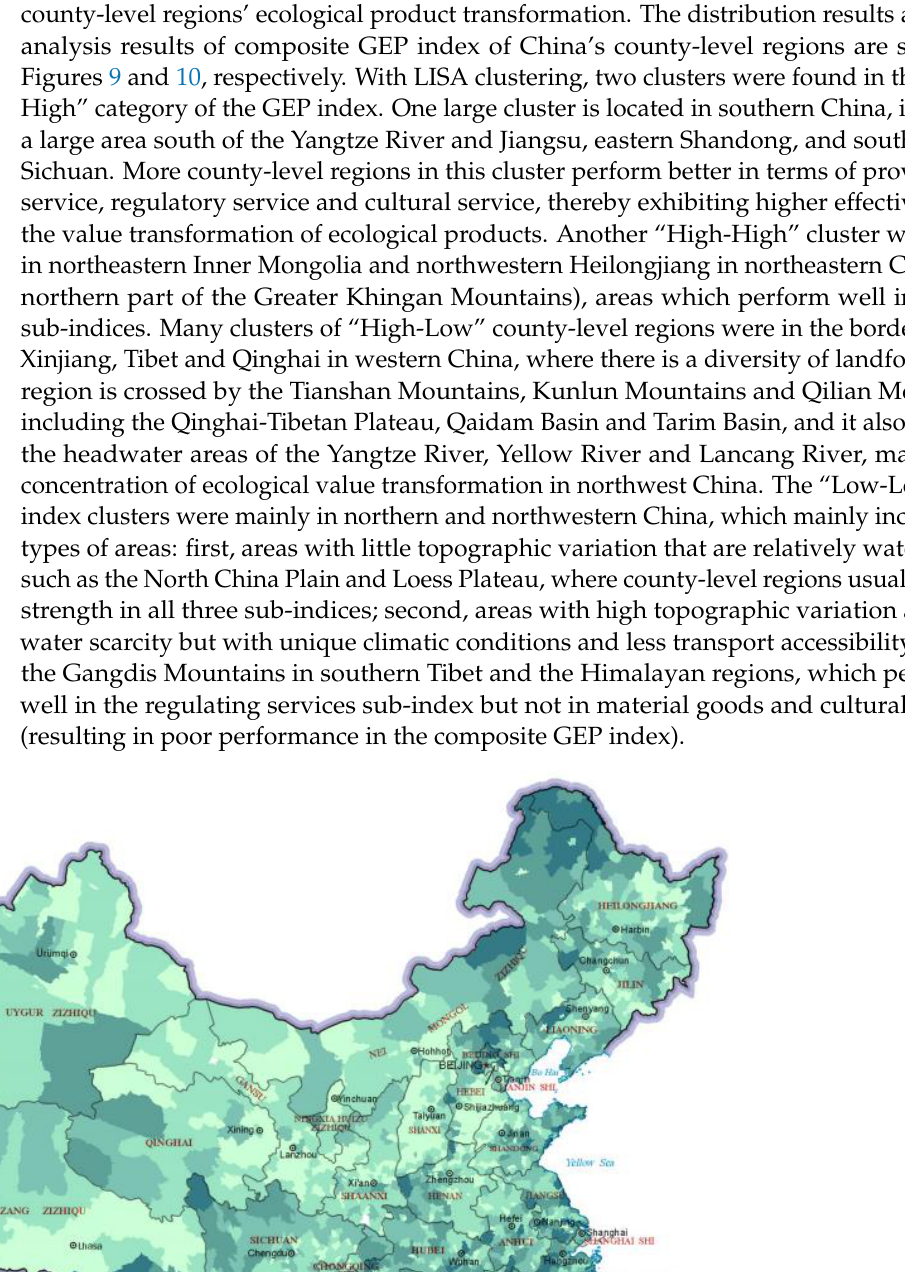
Figure 10. LISA cluster map of composite GEP indices of the county-level regions in China. 4. Discussion So far, many scholars have carried out research with ecological product value evalu- ation, though most of them researched at a city or region scale [15 – 19]. These studies have provided useful explorations for GEP technical methods, but they have not conducted a comprehensive study of the overall spatial patterns and underlying mechanisms on a larger scale. In 2017, Ma used the GEP method to evaluate China’s terrestrial ecosystem value and analysed the spatial pattern at the province level [21]. This study pointed out that the spatial differences of China ’ s GEP are relatively large, among which the total val- ues of GEP in Inner Mongolia and Heilongjiang were the highest, followed by Tibet, Si- chuan, Guangdong and Yunnan. Compared with Ma’s research, we ev aluated China’s ecological product value at a county-level, improving the fineness and granularity of the spatial pattern. We also optimized the evaluation indices system, adding some indices such as species conservation, nutrient cycling, landscape value, etc. The new system ena- bles the ecological value of some ecological high-quality urban areas and woodlands to